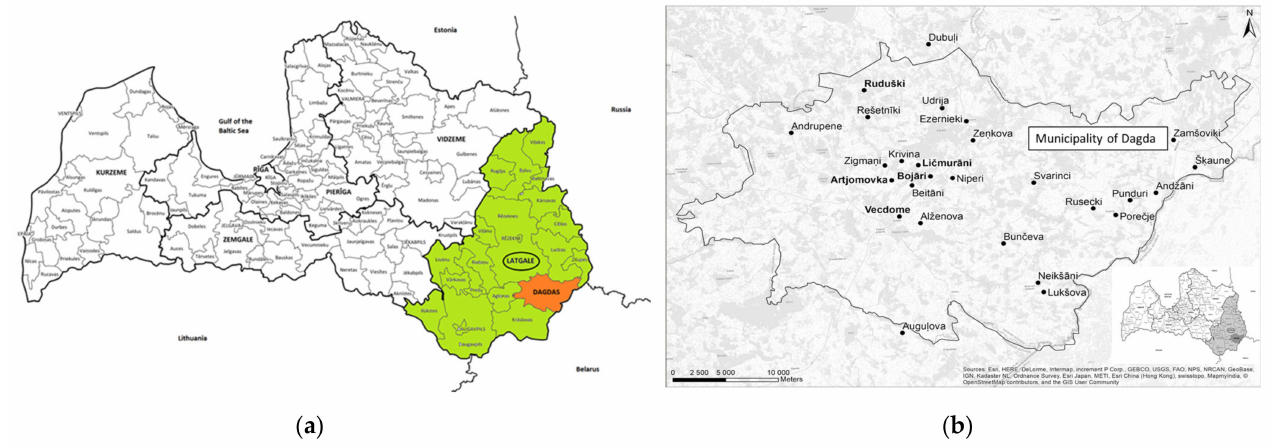
Figure 1. Map of the study sites (territorial division of 2016) ( a ); study sites across Dagda municipality ( b